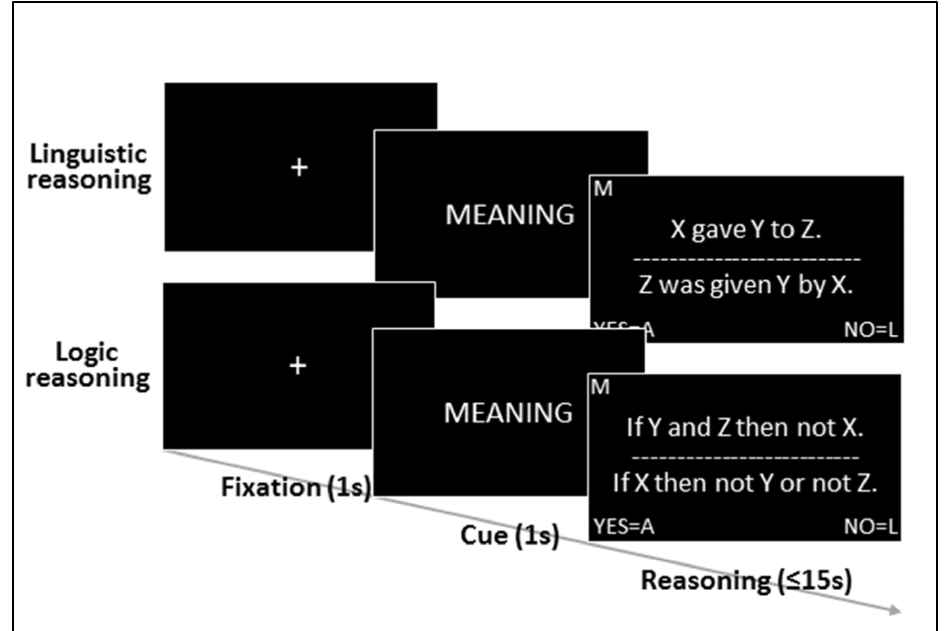
Figure 1. Timeline and sample trials for a linguistic reasoning and a logic reasoning trial (see Table 1 for sample grammaticality judgment trials).